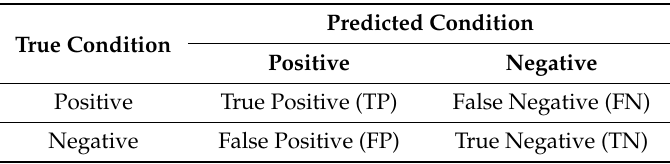
Table 2. Confusion